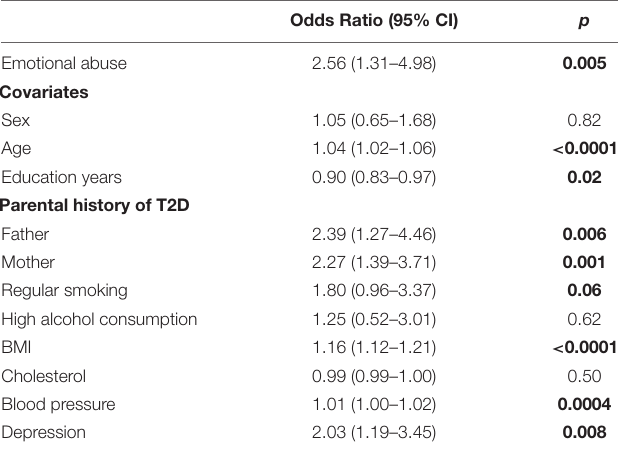
T2D, type 2 diabetes; CI, confidence interval. *p-values numbers marked in bold indicate numbers that are significant on the 95% confidence limit.